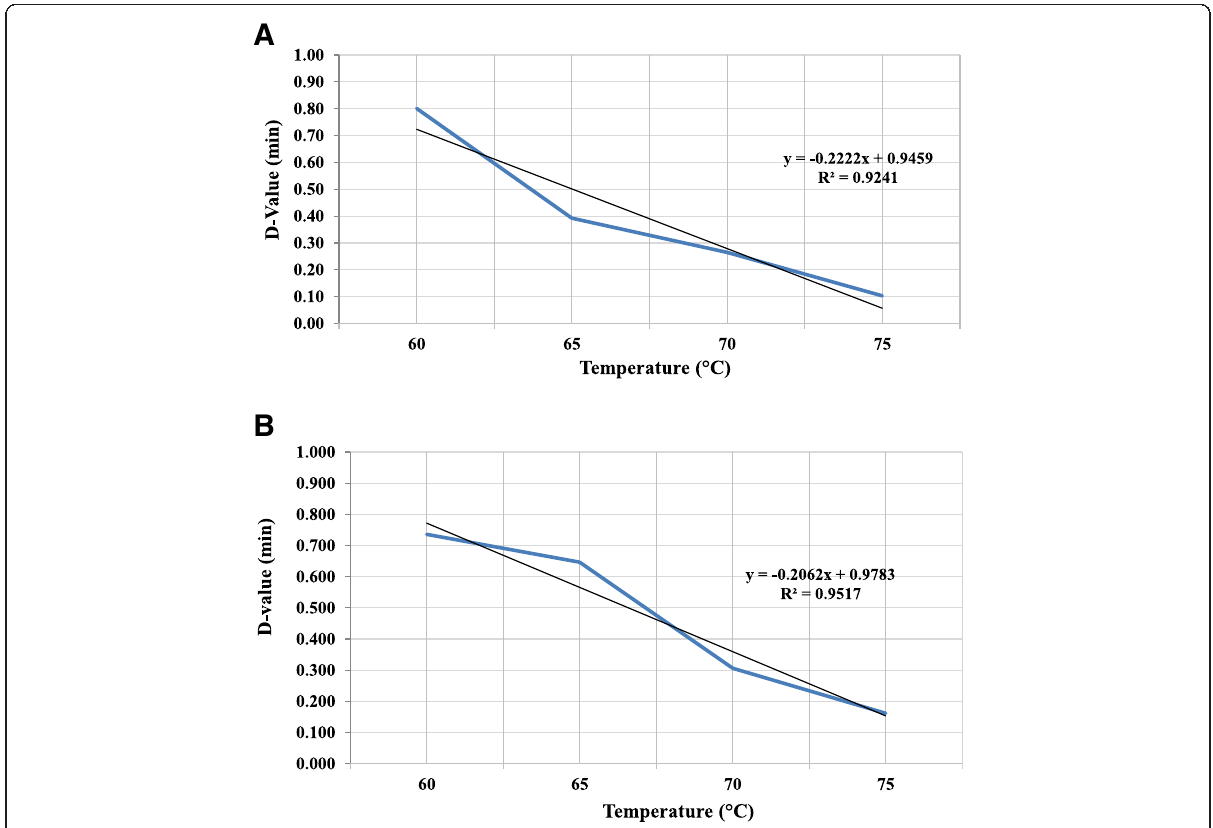
Fig. 2 Z value determination curves of S. typhimurium ( a ) and S. choleraesuis ( b ) grown under different